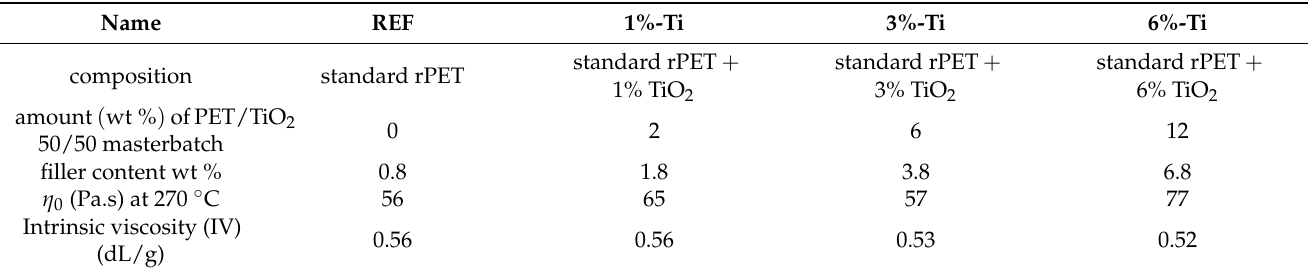
Table 3. Characteristics of the extruded blends between standard rPET and masterbatch PET/TiO 2